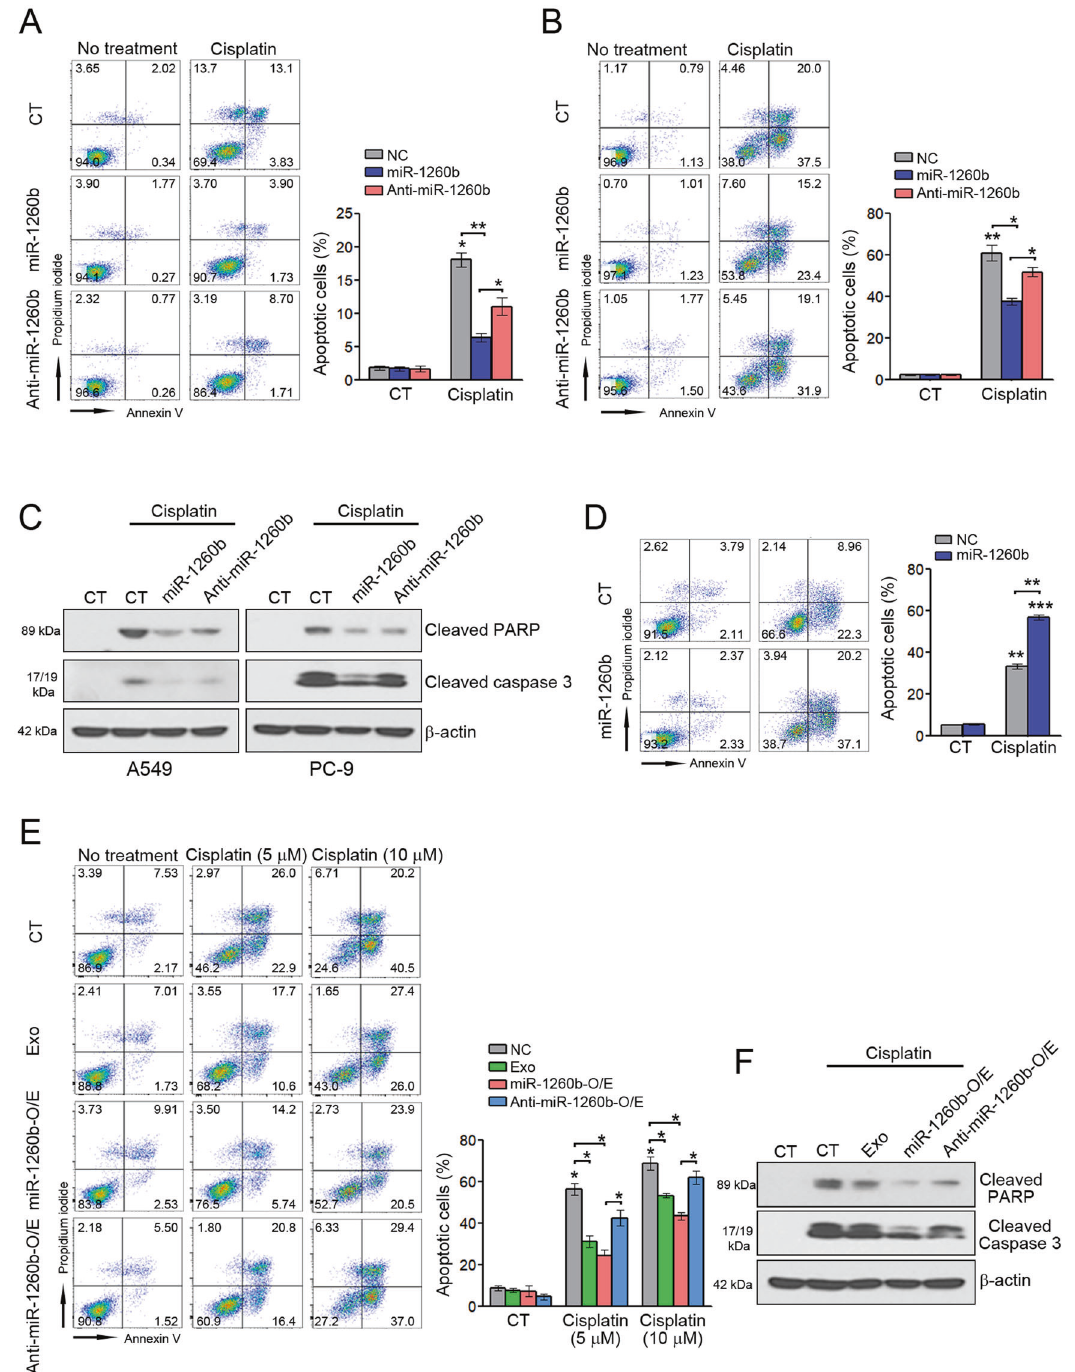
Fig. 3 Effect of exosomal miR-1260b on cisplatin-induced apoptosis. A A549, B PC-9, and D Calu-1 cells were transfected with 50 nM control miRNA (CT), miR-1260b mimic, or anti-miR-1260b mimic for 24 h and then treated with 10 μ M cisplatin for 48 h. Apoptosis was measured by fl ow cytometry. C Cleaved PARP and caspase-3 were detected by western blotting. E PC-9 cells were treated with 50 μ g exosomes from A549, miR-1260b-overexpressing A549, or anti-miR-1260b-overexpressing A549 cells and treated with the indicated doses of cisplatin for 48 h. Apoptosis was measured by fl ow cytometry. F Cleaved PARP and caspase-3 were detected by western blotting. The results are reported as the mean ± standard deviation of three independent experiments. * P < 0.05, ** P < 0.005, *** P < 0.0005 compared with the control group.